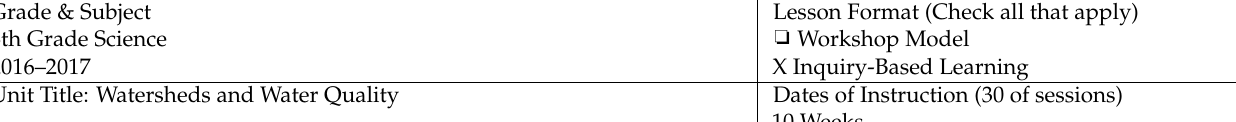
Table A1. Avenue School Unit Plan, Page 1. Table A1. Cont.